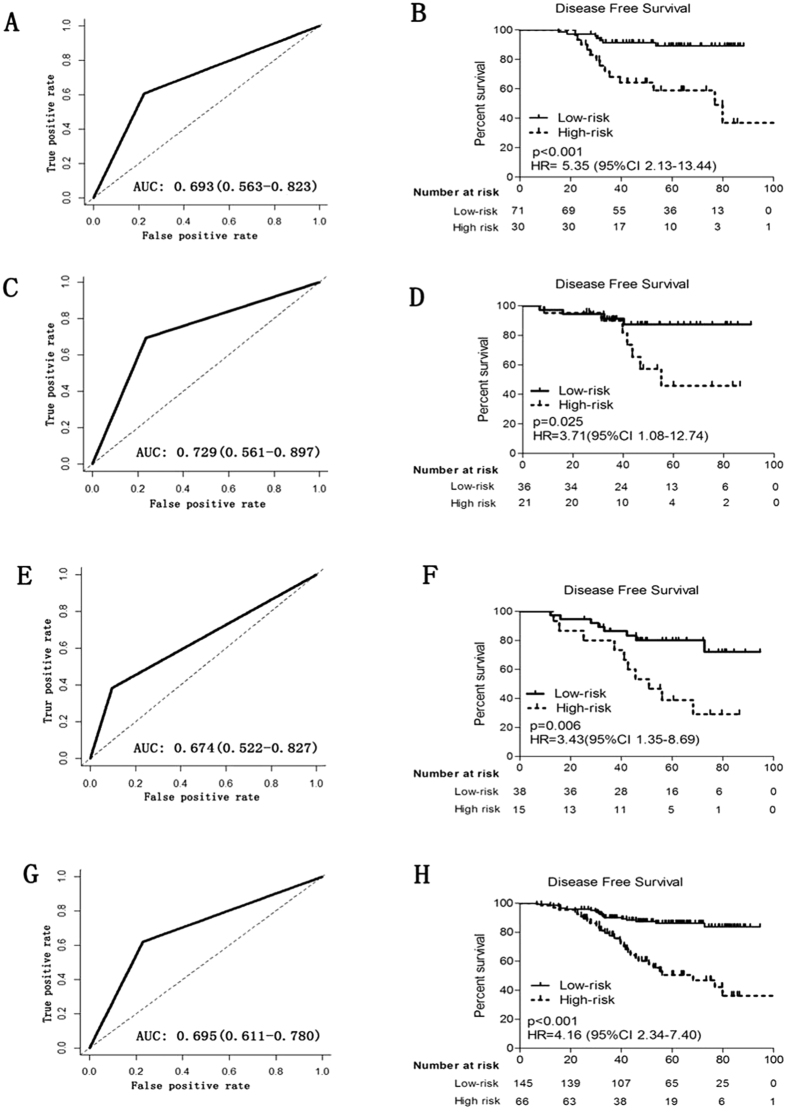
Stratified by the 2 miRNA-based classifier, time-dependent ROC curves and Kaplan-Meier survival of the training, internal testing, external independent sets and combination set.Data are AUC (95% CI) or hazard ratio (95% CI). ROC = receiver operator characteristic. AUC = area under the curve. Training cohort.(A,B) internal testing cohort. (C,D), external independent validation cohort (E,F) and combination set(G,H). We used AUCs at 5 years to assess prognostic accuracy, and calculated p values using the log-rank test.